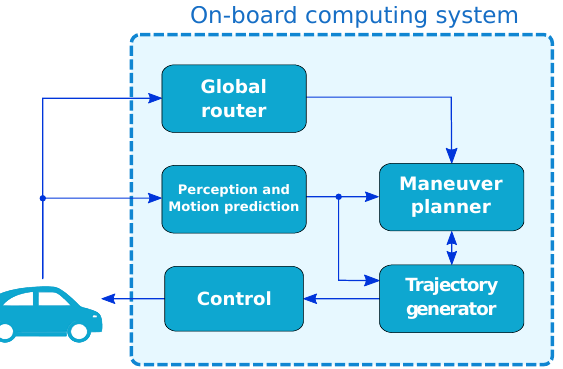
Figure 1. Block diagram of motion planning